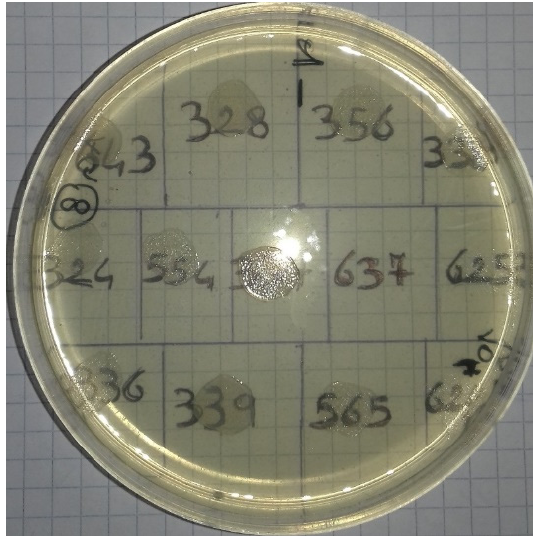
Figure 4. Salmonella strains. Numbered grid used for the identification of strains.